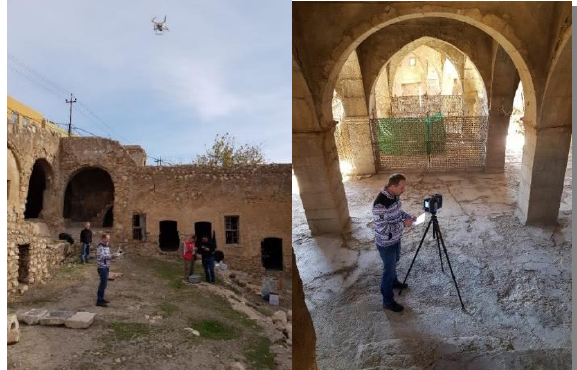
Figure.2. First picture: an example of measuring by the Faro laser scanner, second picture: view of the digital scanning by RPAS (Remotely Piloted Aircraft System) DJI Phantom 4